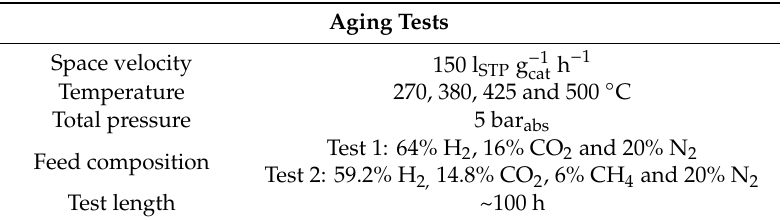
Table 9. Aging test matrix.